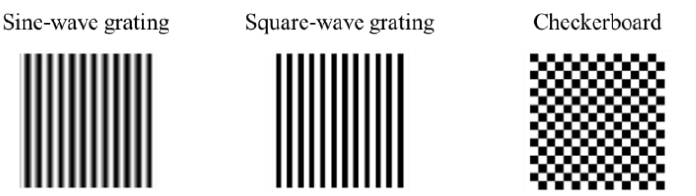
Figure 3. Three typical stimulus patterns of sine-wave and square-wave gratings, and checkerboards used in VEP acuity assessment.